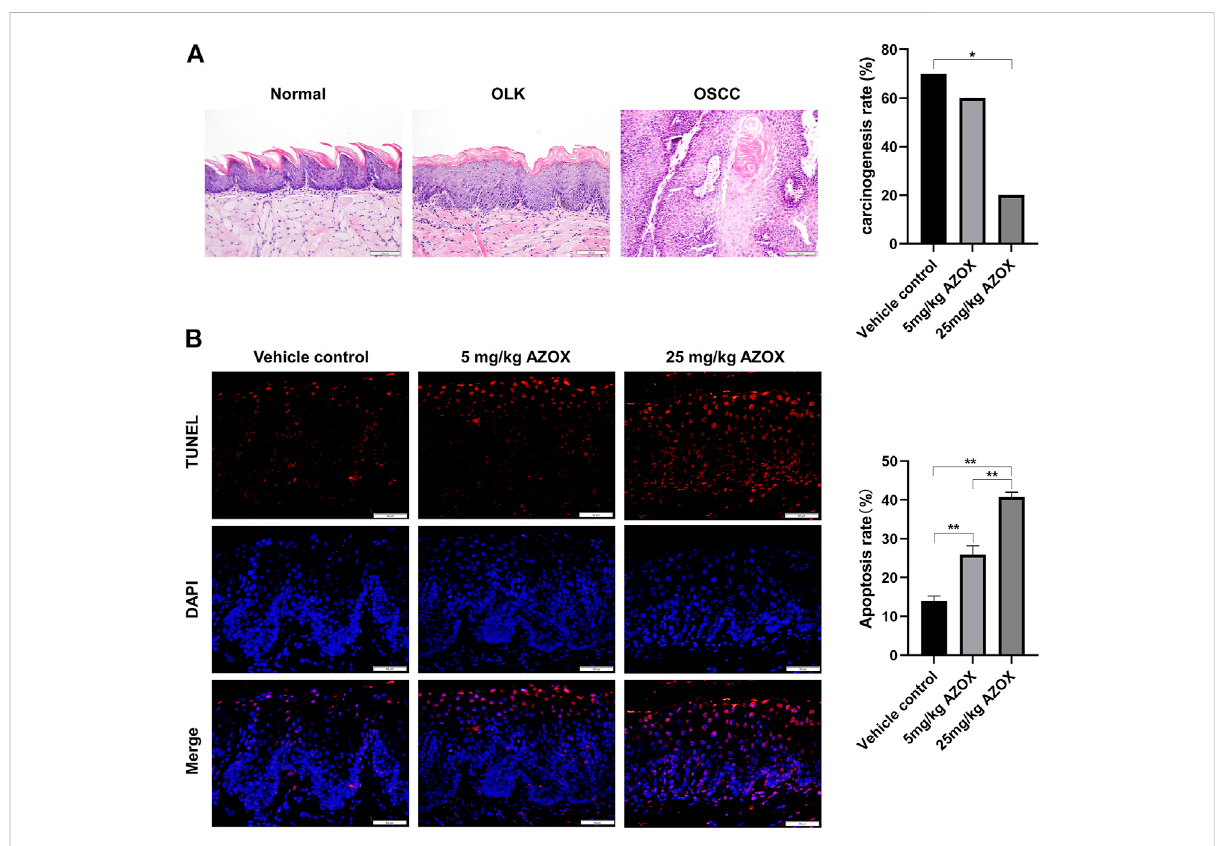
FIGURE 3 AZOX inhibits the malignant transformation and induces apoptosis in mouse OLK tissues. (A) Histopathology of the tongue tissues in mice (magni fi cation 200 × ), and the carcinogenesis rate in the vehicle control group, low- and high-dose AZOX group. (B) Representative images of TUNEL staining results in the vehicle control group, the low- and high-dose AZOX group (magni fi cation 400 × ), and the relative apoptosis rate was calculated using ImageJ software and shown as a bar graph. * p < 0.05, ** p <